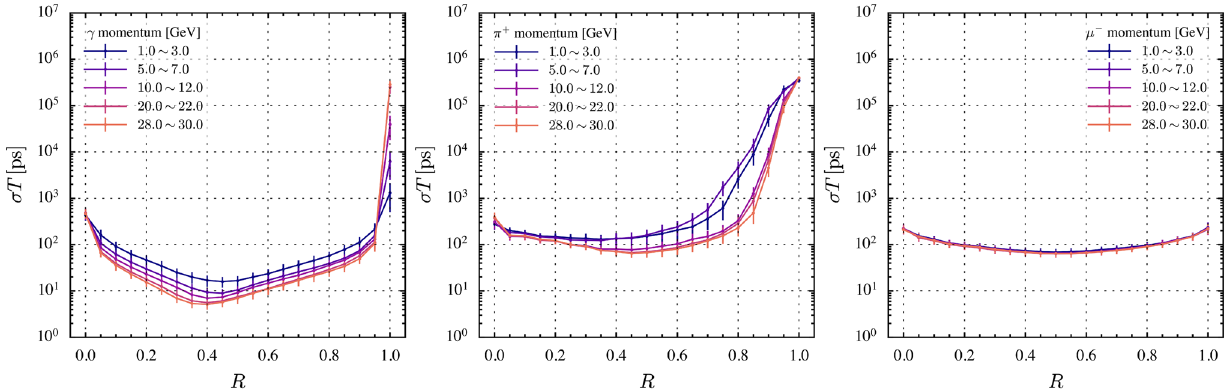
Fig. 9 Bias of reconstructed shower time in γ (left), π + (middle), μ − (right) samples as a function of R . The errors are all scaled with a factor of ten, and also in Fig. 10